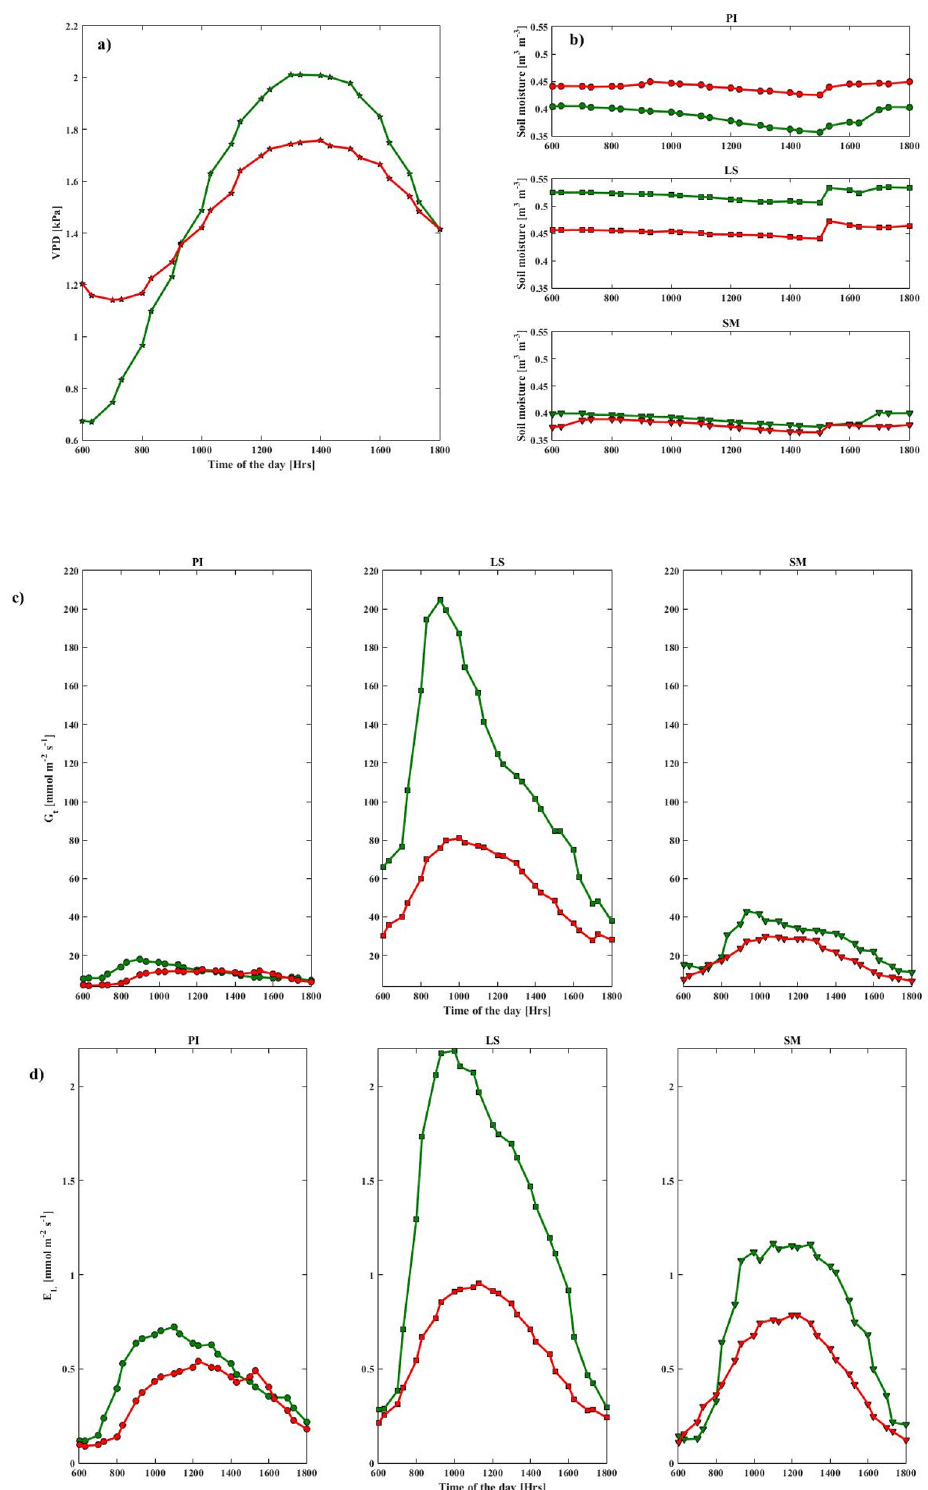
Figure 3. Hourly variations in ( a ) vapor pressure deficit (VPD; kPa), ( b ) soil moisture (m 3 m −3 ), ( c ) canopy conductance ( G t ; mmol m −2 s −1 ) and ( d ) whole-tree transpiration ( E L ; mmol m −2 s −1 ), averaged over 6 AM to 6 PM LT of all days in the study period, during the dry and wet season. Columns correspond to the three species ( P. indicus (PI); leftmost panel, L. speciosa (LS); middle panel, and S. macrophylla (SM); right panel) and seasons plotted in green (wet) and red (dry) symbols. This figure was generated using MATLAB version 7.12.0 R2017a (https ://www.mathw orks.com/produ cts/new_produ cts/relea se201